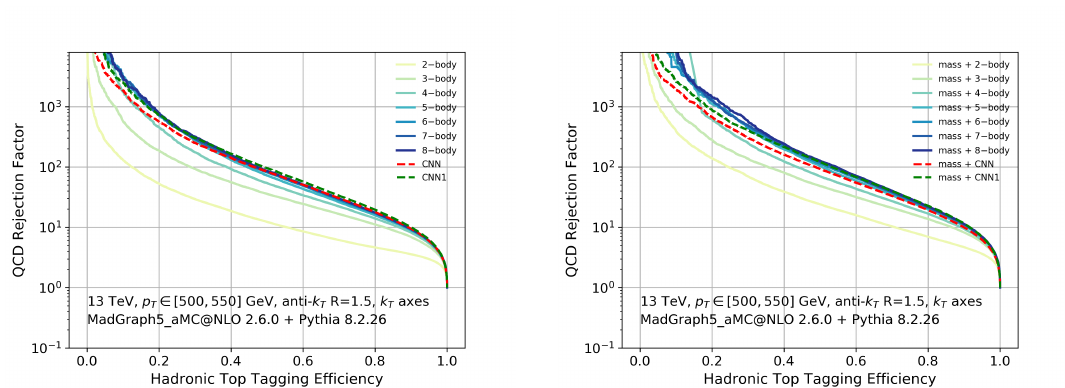
Figure 5: ROC curves for top quark tagging without mass on the left and with mass ∈ [ 500,550 ] GeV. In this case the performance after adding mass on the right, for p T information is very similar.